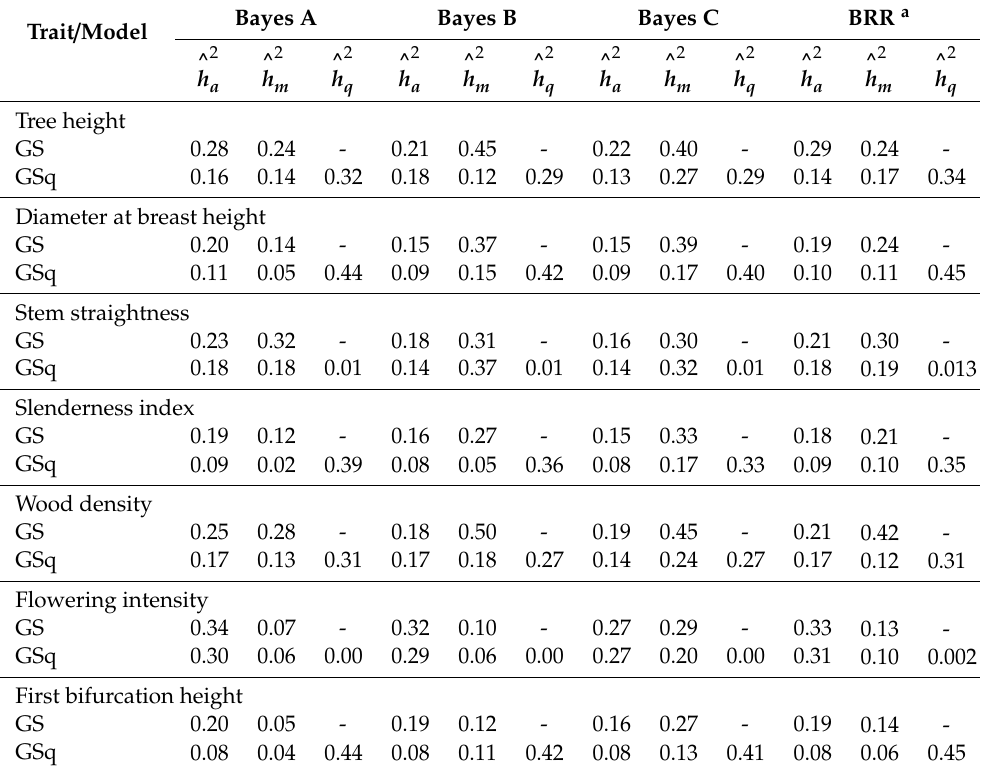
Table 3. Estimates of heritability of the studied traits for each Bayesian genomic model and e ff ect (i) polygenic background (pedigree information) and all informative markers (GS model), and (ii) polygenic background, QTL-genotype e ff ects (determined by GWAS) and SNP markers that were not associated with any trait (GSq model). ˆ h 2 a corresponds to the pedigree-based estimated heritability. ˆ h 2 m is the heritability estimate based on a set of markers that were not found to be significantly associated with a trait (GSq) or all SNP markers (GS), ˆ h 2 q represents the heritability estimates based on a set of SNPs significantly associated with a